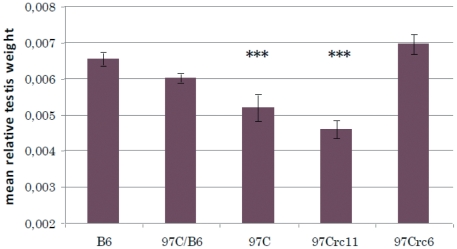
Relative Testis weight of parental B6 and IRCS 97Crc6, 97Crc11, 97 C.97 C encompasses two chromosome segments of spretus origin on chromosomes 6 and 11. The 97Crc6 and 97Crc11 sub-recombinant were generated to separate the two fragments. Clearly the small testis weight phenotype segregates with chromosome 11. Results are expressed as mean ± SEM. Asteriks (***) denote strains that showed a significant difference when compared to B6 (P<5.10−7).